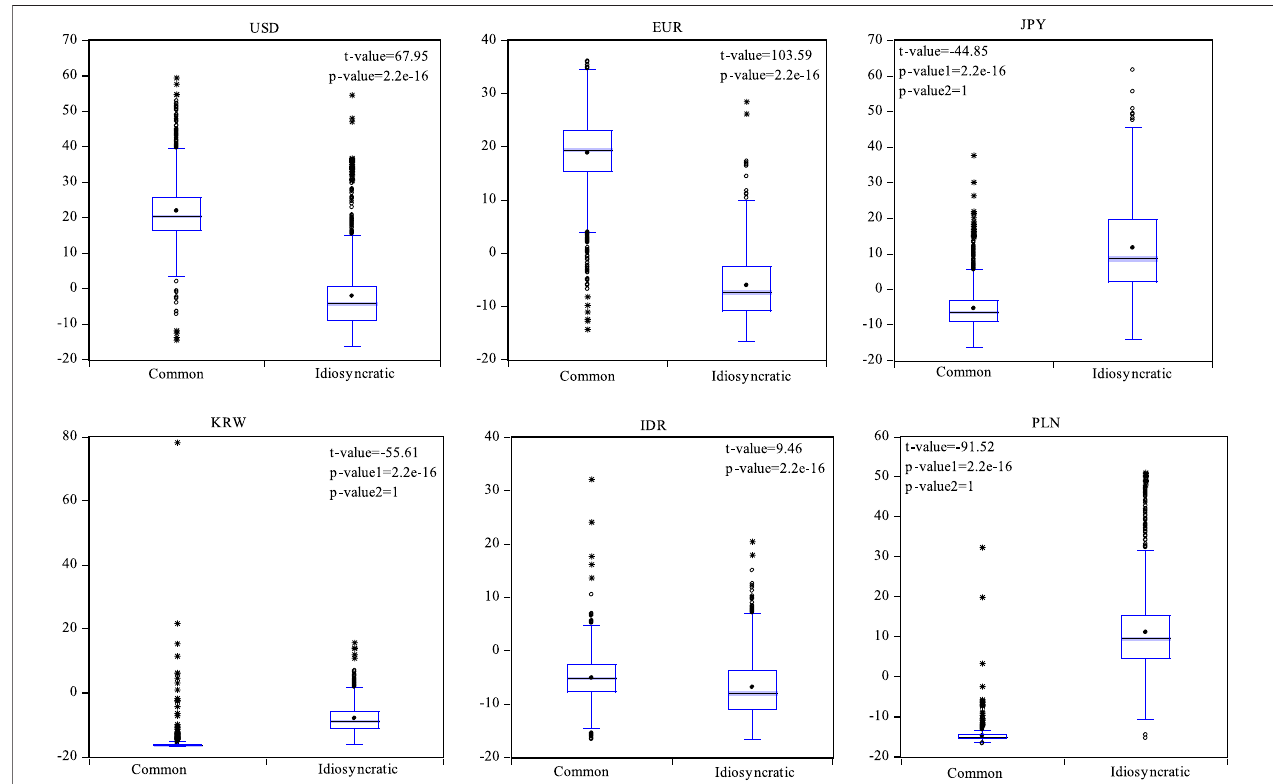
FIGURE 5 | Test results of net spillover between systematic and idiosyncratic volatilities ( p < 0.05). Note: I: The boxplot show the dynamic net pairwise spillovers of systematicandidiosyncraticvolatilitiesamongtheBitcoinmarkets.II:Thet-valueisthevalueoft-statistics.The p -value1isthe p -valueoftest(1).The p -value2isthe p -valueof test (2). If both the p -value1 and p -value2 are smaller than 0.05, then it is replaced by p -value. III: Test (1): TAM 1 i (cid:1) 0 . vs TAM 1 i ≠ 0. Test (2): TAM 1 i < 0 . vs. TAM 1 i > 0